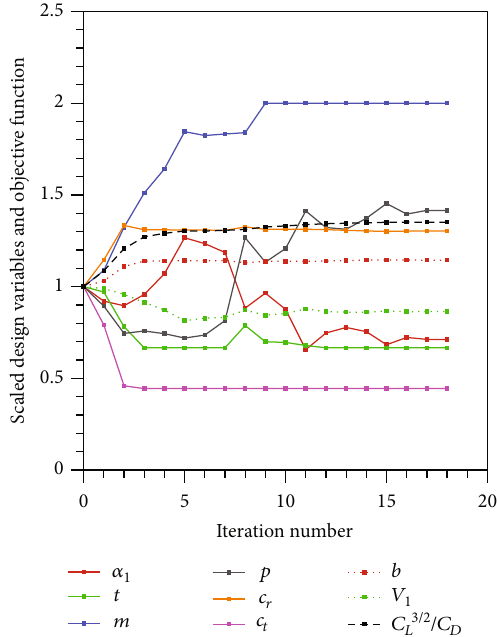
Figure 16: The variation of the objective function and the design variables in Case 2.